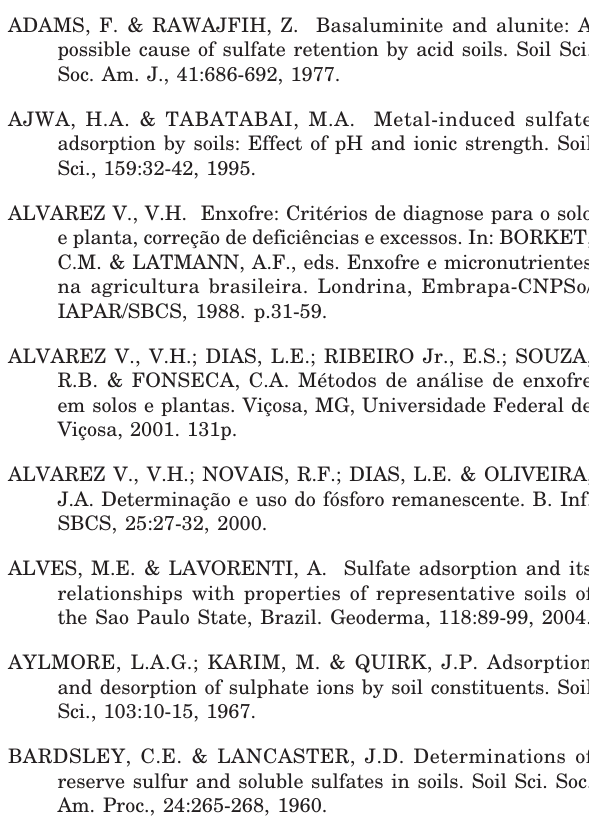
(1) Tempo de incubação (d); (2) P-rem: fósforo remanescente (mg L -1 ); (3) CO: carbono orgânico (dag kg -1 ); (4) CMAS máxima de adsorção de sulfato (mg dm -3 de S); (5) CMAS H significativo a 10, 5, 1 e 0,1 %,